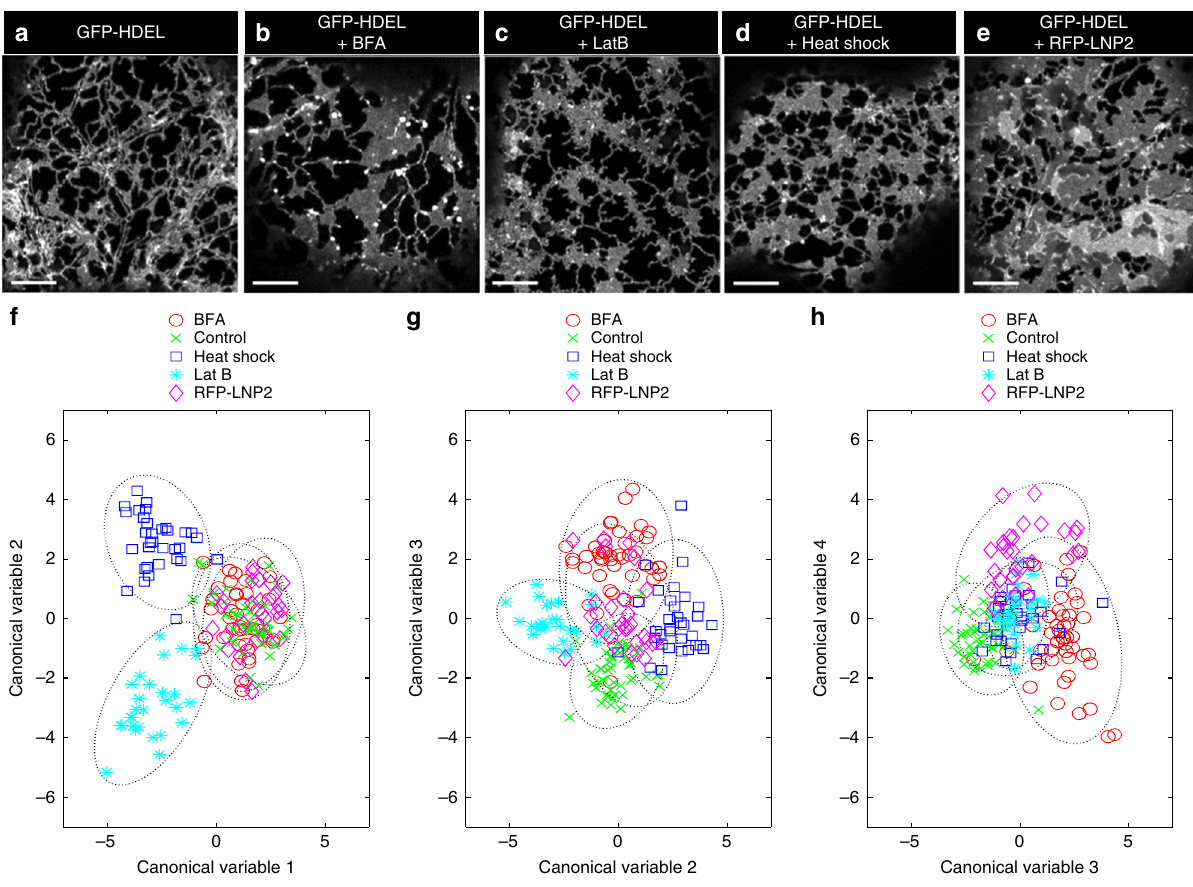
Fig. 6 Multivariate analysis of ER morphology and dynamics. Representative single optical sections of tobacco leaf epidermal cells transiently expressing GFP-HDEL ( a , n = 46); after treatment with BFA ( b , n = 46); Lat B ( c , n = 28); heat shock ( d , n = 33); or over-expression of RFP-LNP2 ( e , n = 29), where n is the number of independent 5-frame time-series images. All scale bars = 5 µ m. Pairwise scatter plots of the fi rst 4 signi fi cant canonical variables from the MANOVA analysis grouped by treatment ( f – h ). The dotted line around each group represents the 95% con fi dence